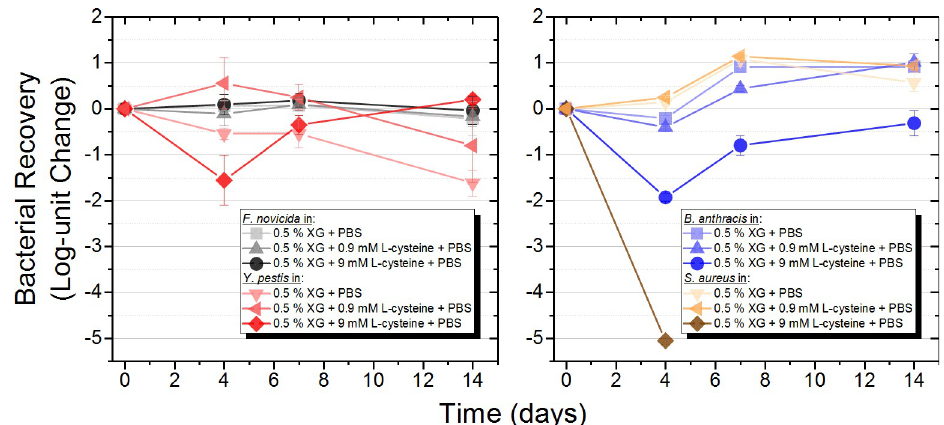
Fig 3. Stabilization of B . anthracis , F . novicida , S . aureus , and Y . pestis over time. Test matrices were spiked with ~10 5 CFU/mL of Gram-negative F . novicida U112 or Y . pestis KIM D27 (pgm-) (left) or Gram-positive B . anthracis Sterne 34F2 or S . aureus ATCC 43300 (right). All were incubated at 22˚C for 14 days. Viable plate counts were conducted at various time points to determine cell stability. Data are the average of three biological replicates and three sample replicates plated in triplicate (n = 9 measurements).